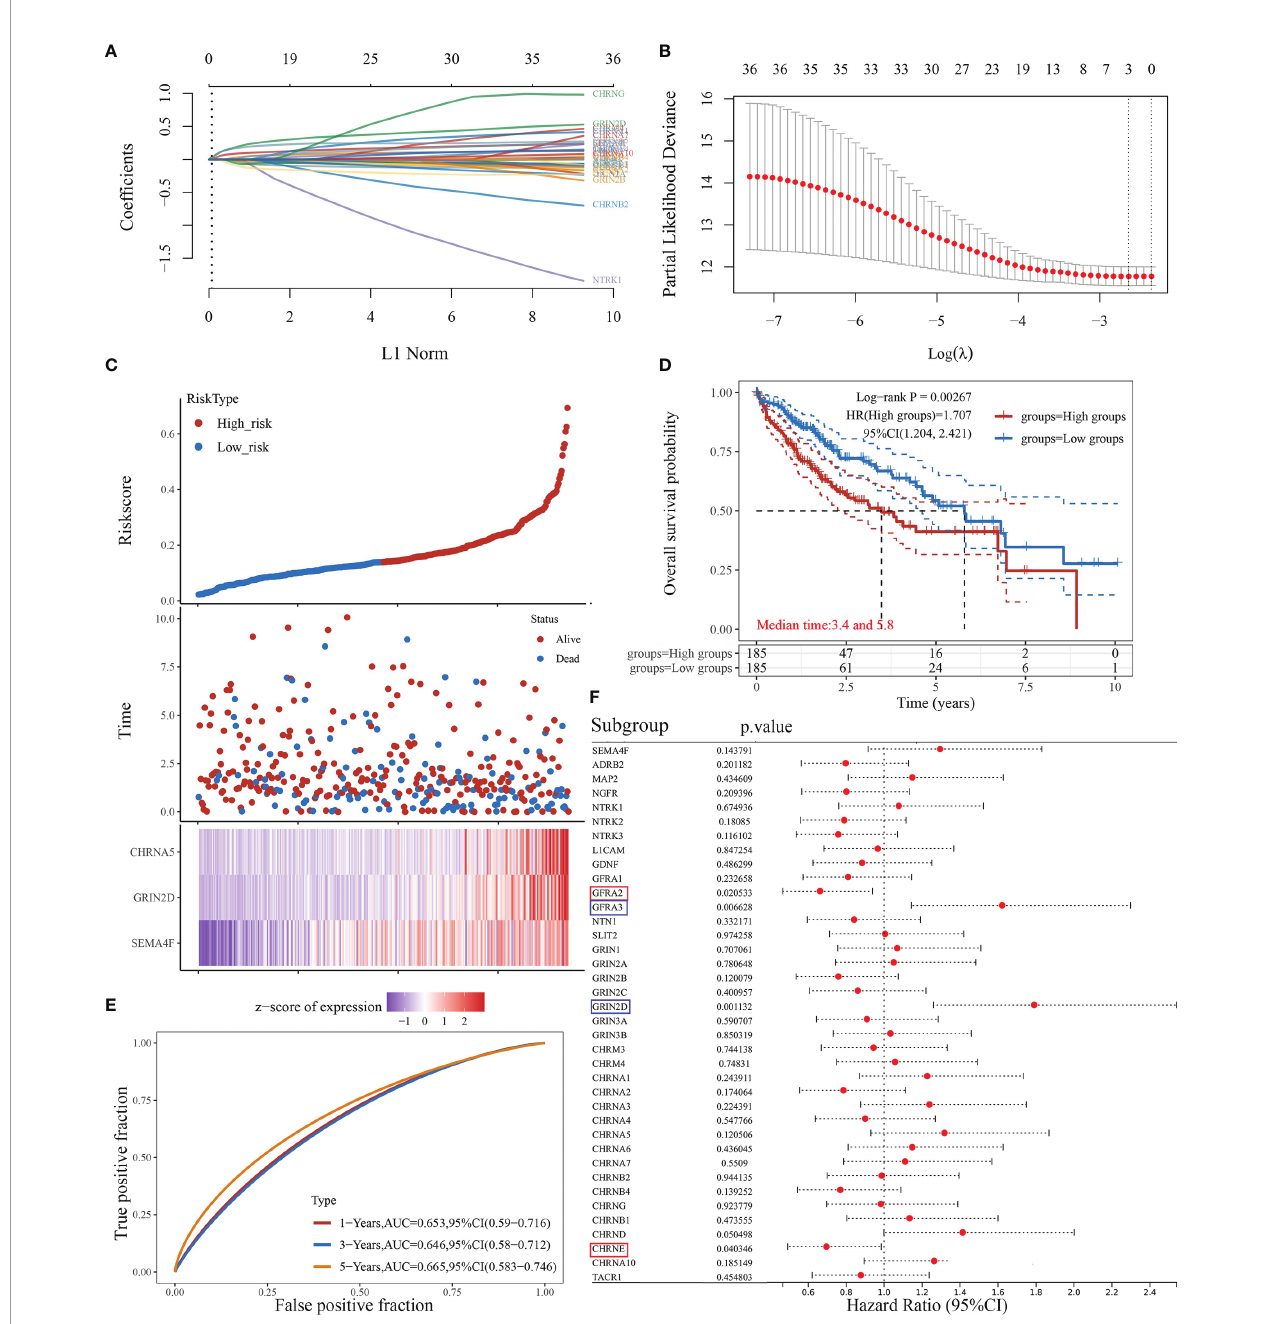
FIGURE 5 | The prognostic model of liver cancer based on 38 neural-related genes. (A) The coef fi cients of 38 neural-related genes shown by lambda parameter. The vertical axis represents the coef fi cients of independent variables, and the horizontal axis represents lambda. (B) LASSO COX regression model was used to draw the partial likelihood deviance versus log( l ). (C) The relationship between risk score and living status. The dotted line represents the risk score and divides the patients into high-risk and low-risk groups. A scatter diagram is in the middle, and the heat map of gene expression is down below. (D) KM survival curve of the risk model in TCGA data set. Different groups were tested by log rank and HR (high exp), and represent the risk factors of the high expression group compared with the low expression group. (E) The ROC curve of the risk model and AUC at various timepoints (1 year, 3 years, 5 years). (F) The univariate COX analysis, the p -value of clinical features, and hazard ratio (HR) con fi dence interval of 38 neural-related gene